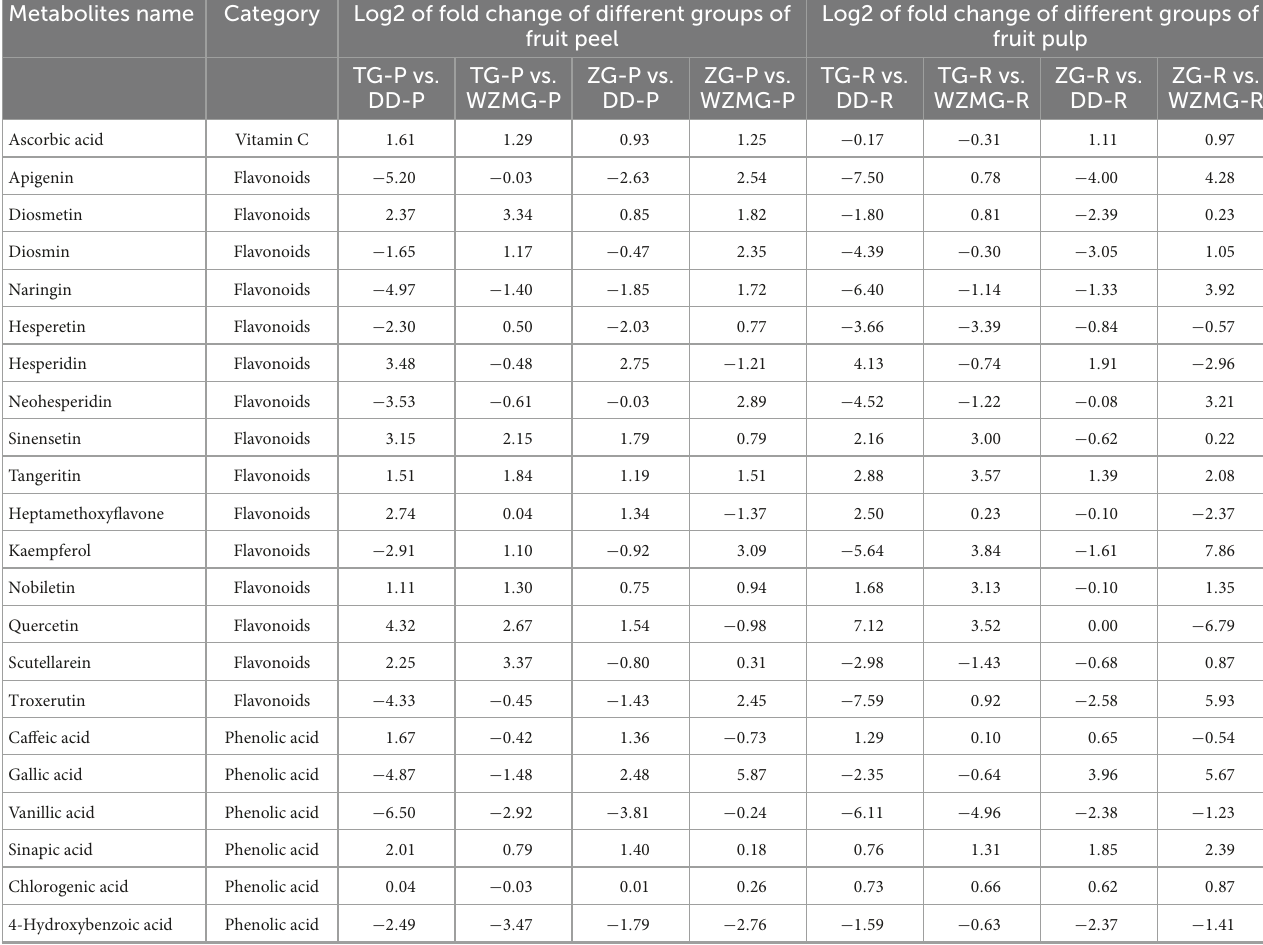
TABLE 2 Represents the log 2 FC of the main flavonoids, phenolic acid, and vitamin C in fruit peel and pulp between different